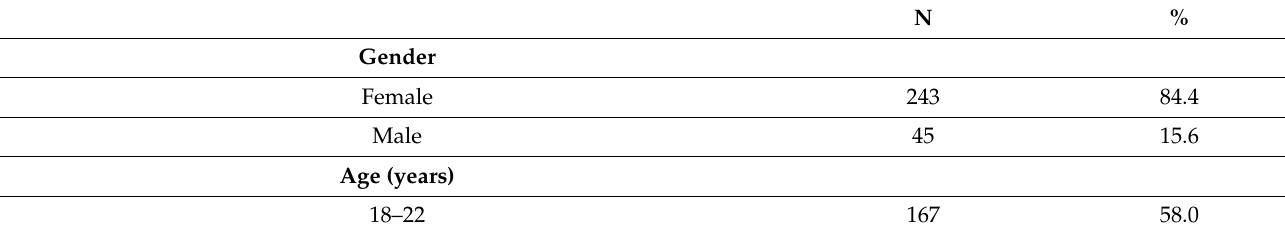
Table 1. Participants’